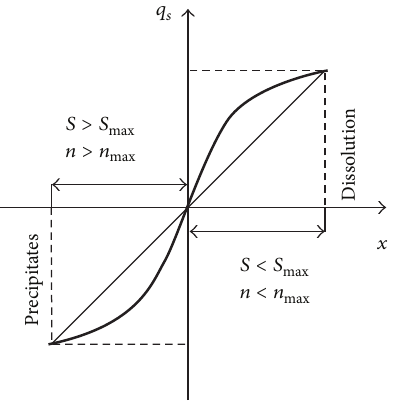
Figure 3: Relationship between solventing speed and greatest sediment